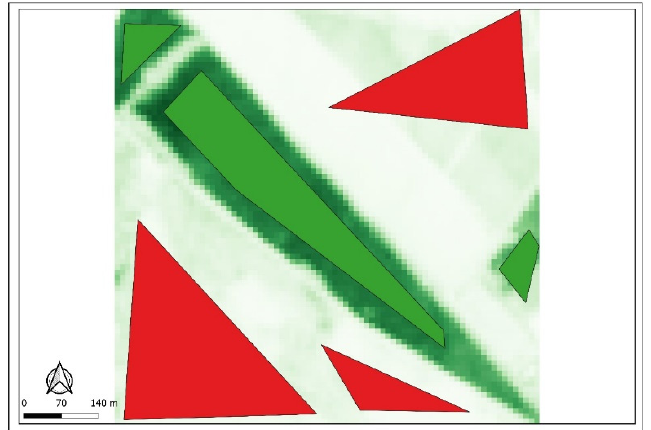
Figure 3. Green polygons symbolise IPG while red polygons symbolise NIG.